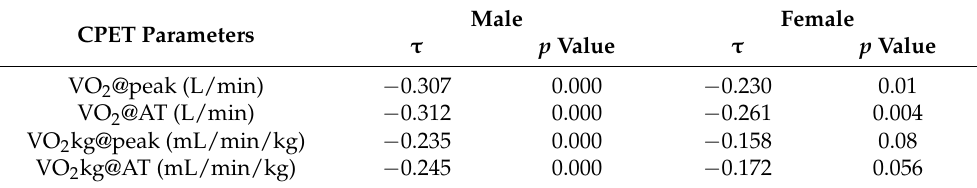
Table 3. The correlation between the number of SCAs and CPET indices.